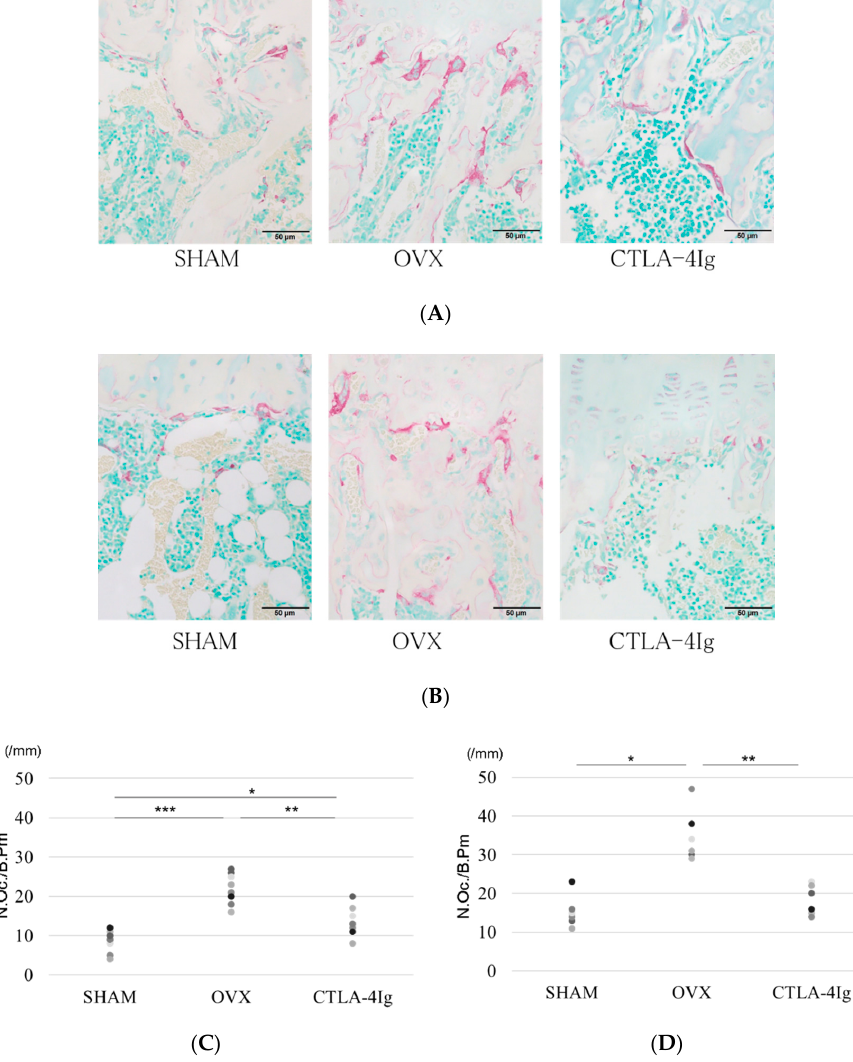
Figure 3. Histological analysis of hindlimb bone. ( A ) Tartrate ‐ resistant acid phosphatase (TRAP) staining for the histological examination of the distal femoral metaphysis scale bar is 50 μ m); ( B ) TRAP staining number of TRAP-positive osteoclasts in the distal femoral metaphysis; ( D ) histological analysis